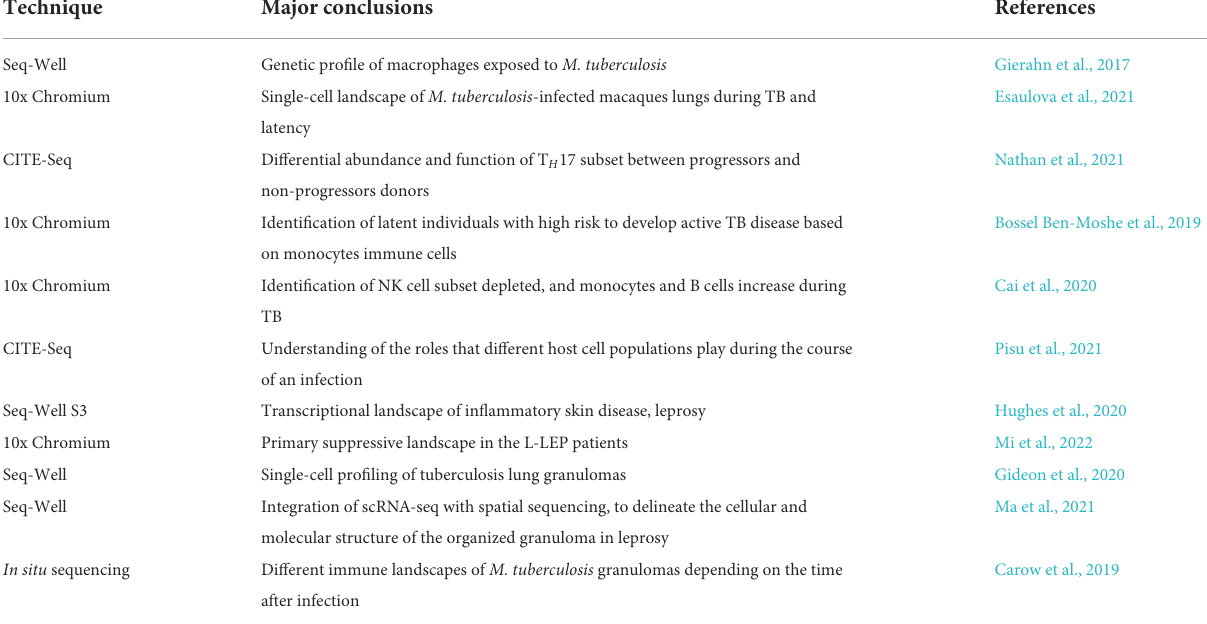
TABLE 2 Summary table containing the technique and major conclusions of the articles discussed in this